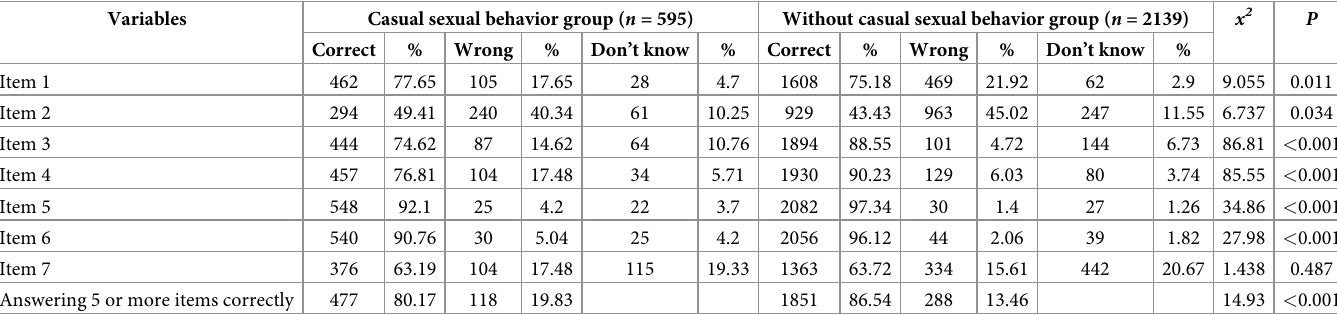
Table 2. HIV/AIDS awareness rate among 2734 male college